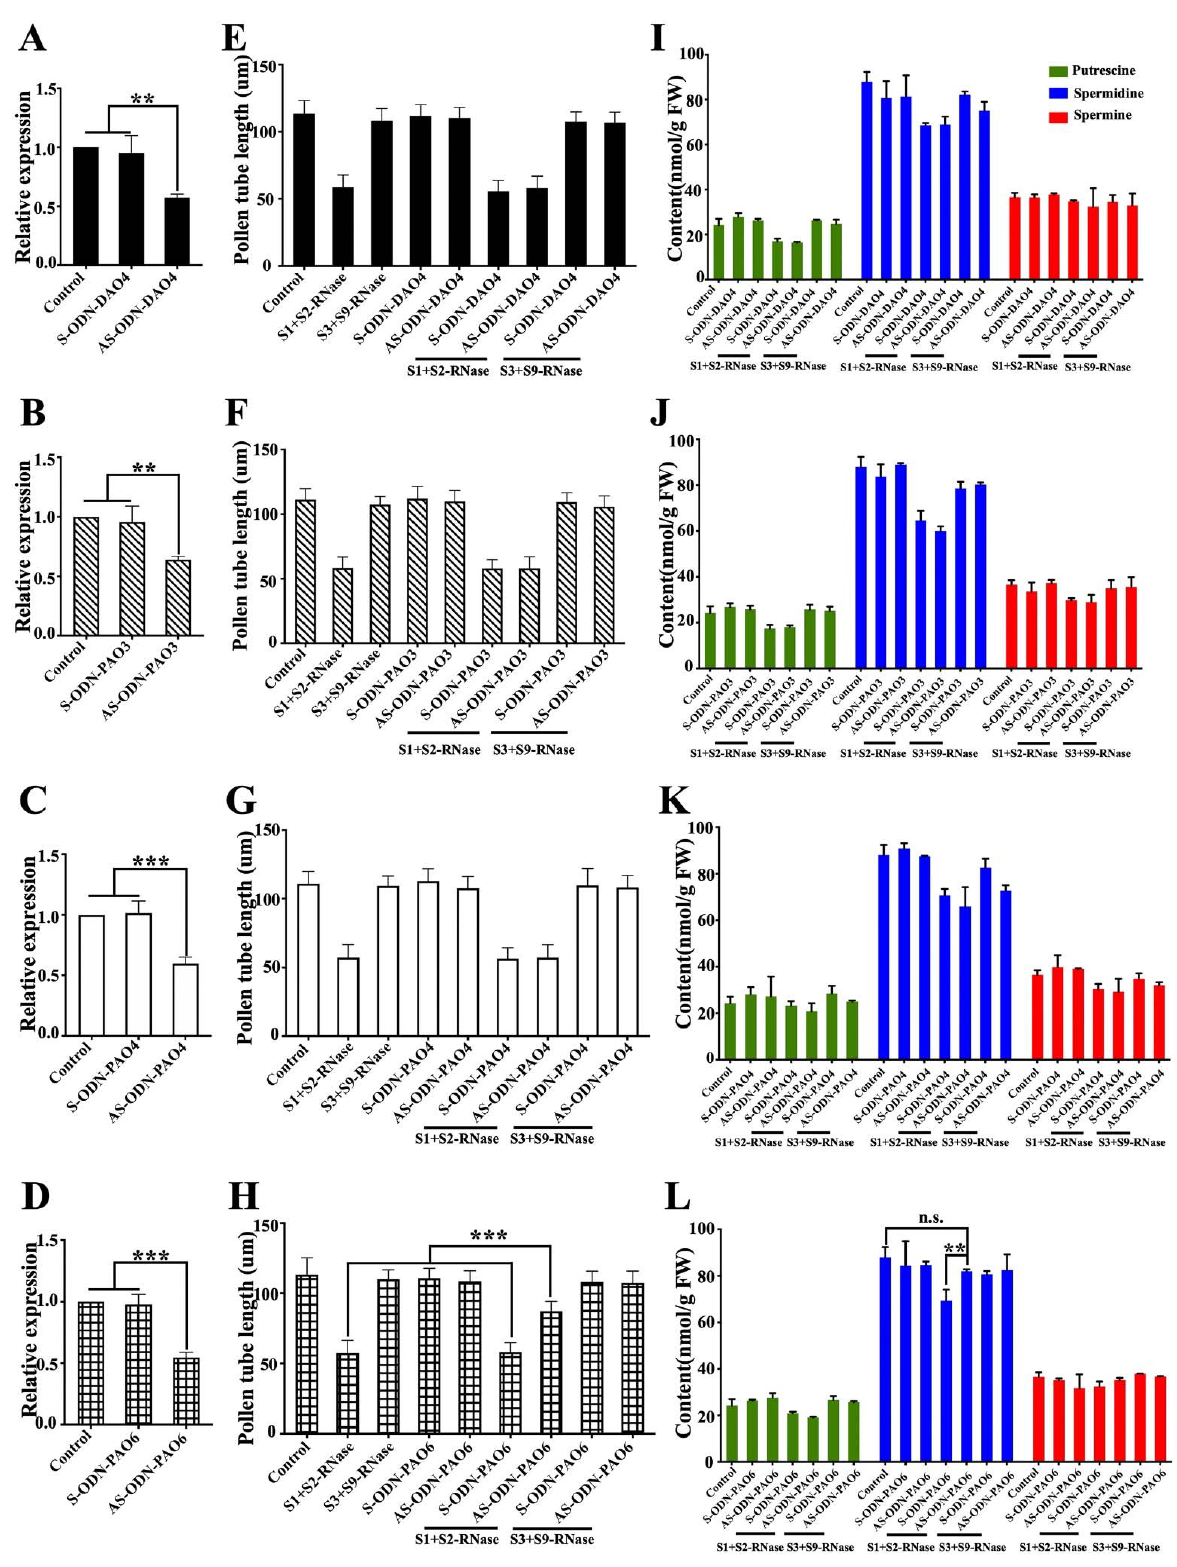
Figure 3. Effect of oxidase genes on pollen tube elongation and polyamine content. ( A – D ) Expression levels of MdDAO4 , MdPAO3 , MdPAO4 , and MdPAO6 in pollen transfected with sense oligonucleotide, antisense oligonucleotide or